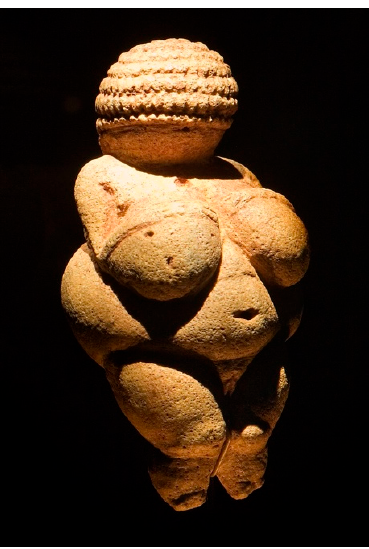
Figure 2. Woman of Willendorf, Willendorf Venus Natural Museum, Vienna, Austria. Photo by Jorge Royan, copyright 2007 Wikimedia Commons (Creative Commons: CC BY-SA 3.0) .